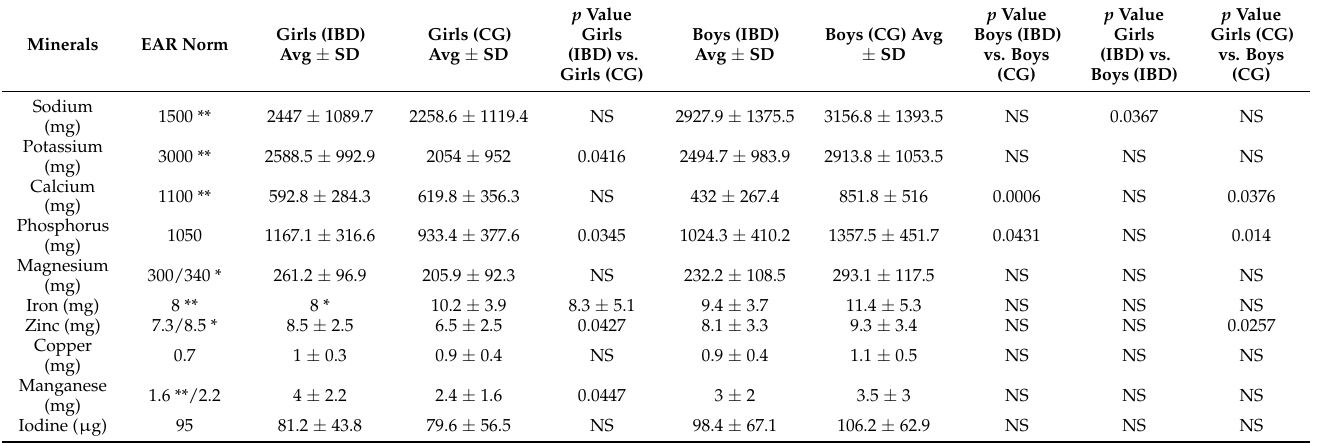
Table 4. A comparison of mineral consumption